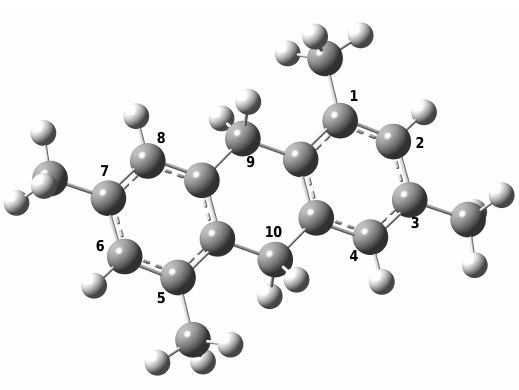
Figure 3. Structure of compound 2 .